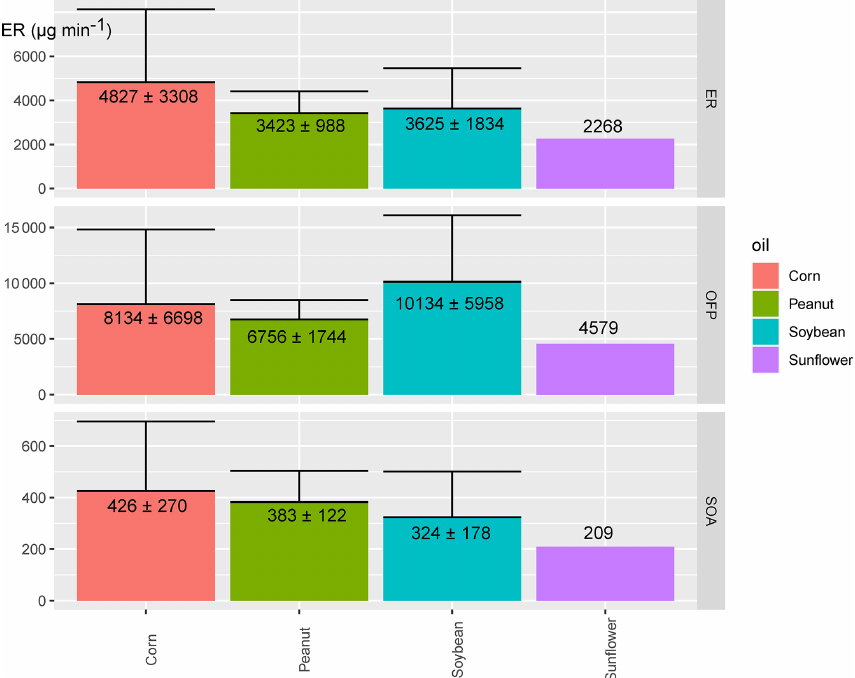
Figure 4. Emission rate (ER), ozone formation potential (OFP), and secondary organic aerosol (SOA) estimation from emissions of fried chicken cooked with corn, peanut, soybean, and sunflower oils. The unit of the y axis is µgmin − 1 .